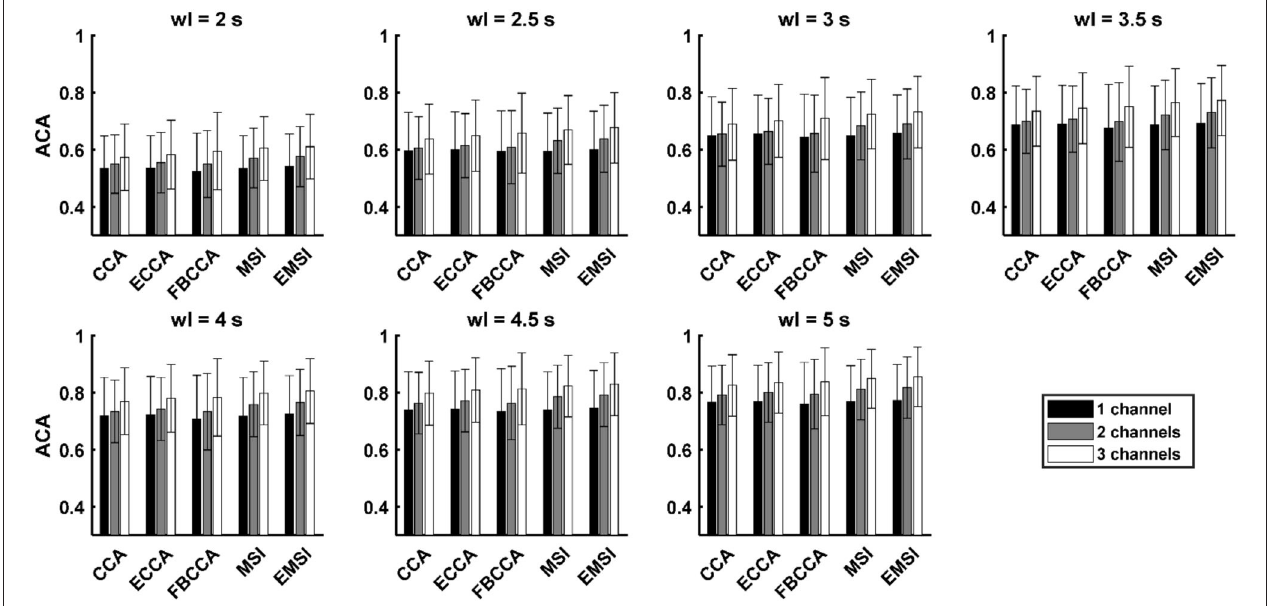
FIGURE 2 | Mean and SD of the average classification accuracy across the electrode shift (ACA) across the subjects with five SSVEP classification algorithms in the case of 3 channels and seven window lengths (wl) (black, gray, and white bars denote the mean accuracies of 1 channel, 2 channels, and 3 channels, respectively; the error bars represent the SD